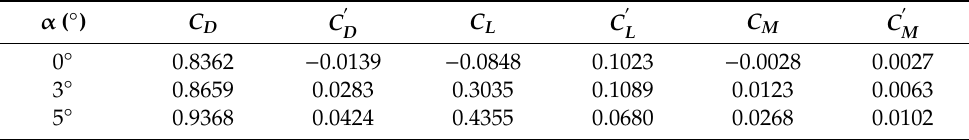
Table 3. Aerodynamic force coefficients and derivatives for the construction stage.